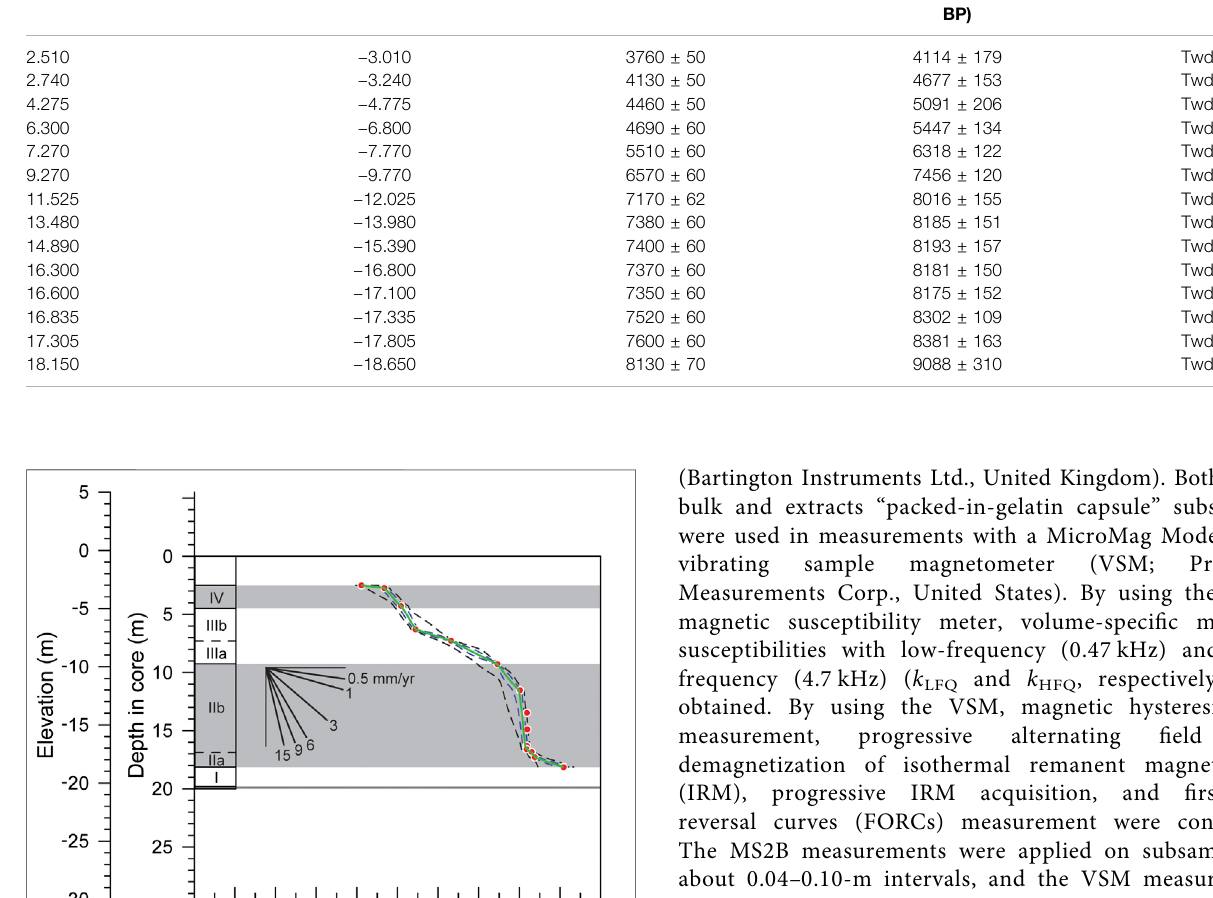
TABLE 1 | Accelerator mass spectrometry (AMS) 14 C age data for materials of terrestrial origin (plant fragments) of the YAR-4 core, selected from the dataset of Nakanishi et al. (2013). Age* denotes a conventional age estimate before 14 C calibration reported in Nakanishi et al. (2013). Age ( ± 2 σ ) in cal. yr BP denotes the calibrated age estimate using the OxCal (version 4.4; https://c14.arch.ox.ac.uk/oxcal.html) and the IntCal20 (Reimer et al., 2020) by this study. Depth in core (m)